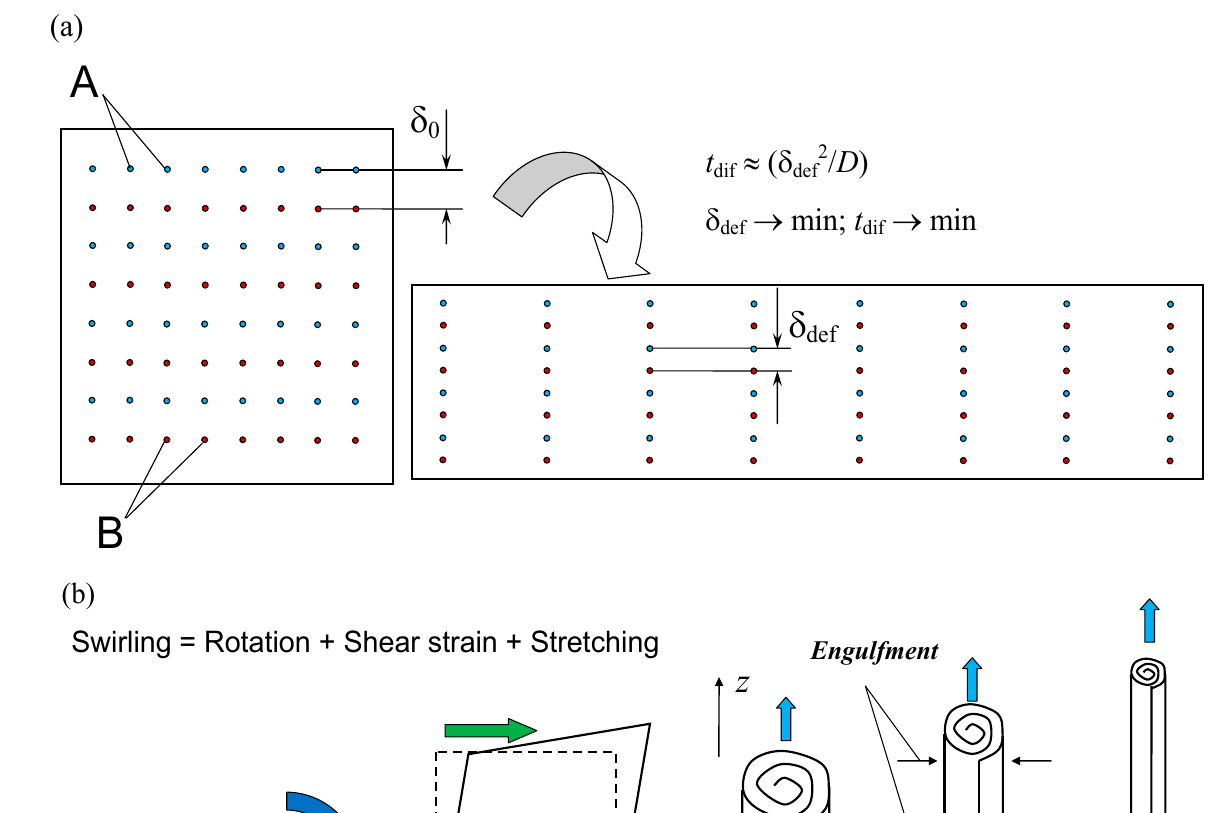
Figure 3. Schematic of the influence of linear ( a ) and angular ( b ) deformations on the process of diffusion of substance spots (concentration spots). The plot is based on the [26] approach.